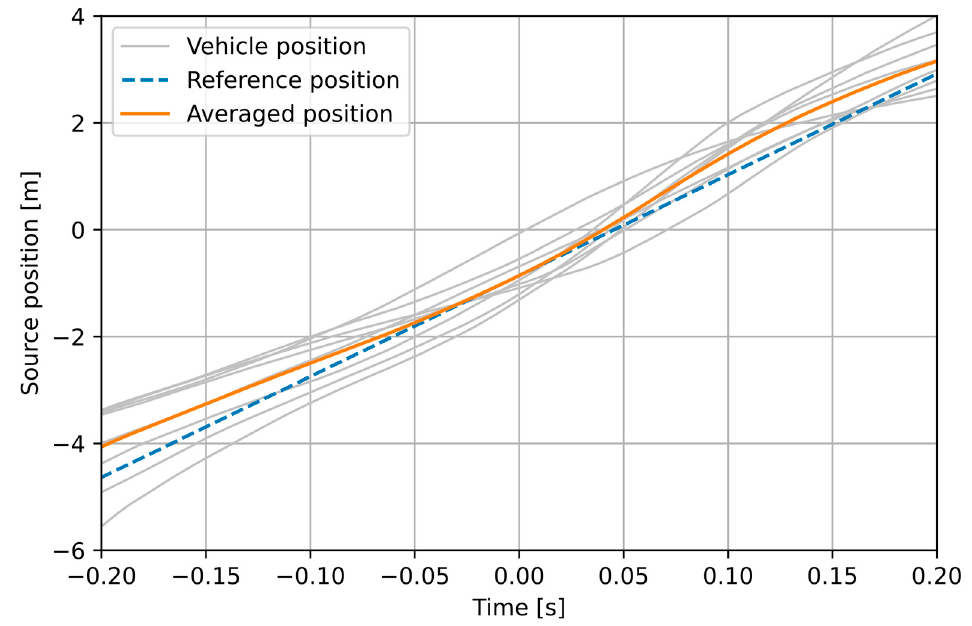
Figure 13. Position signals calculated in the experiment L1.